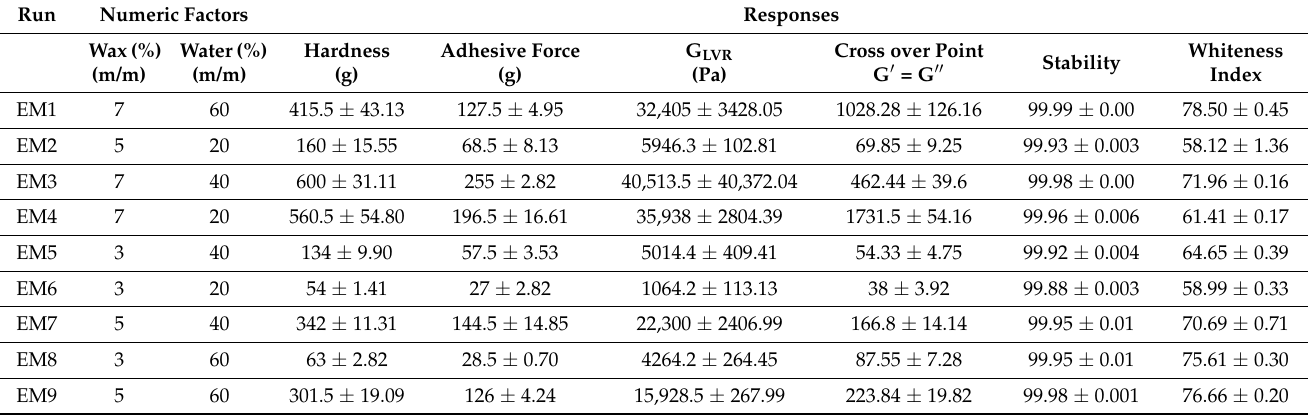
Table 1. Numeric factors (composition of the samples) and response variables for emulsion oleogels formulated with sunflower oil oleogel structured with shellac